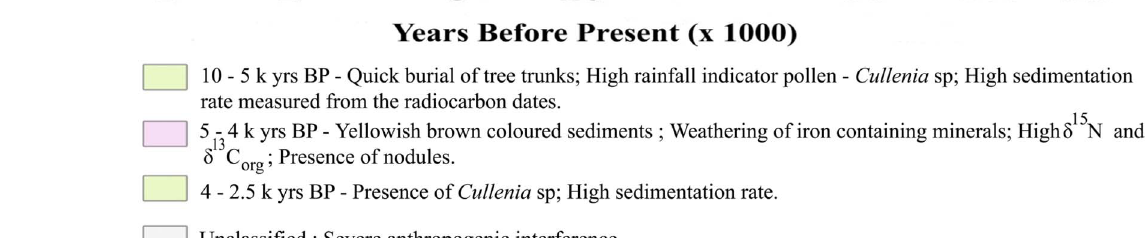
Figure 7. Holocene Climate Model (after [48,52]).